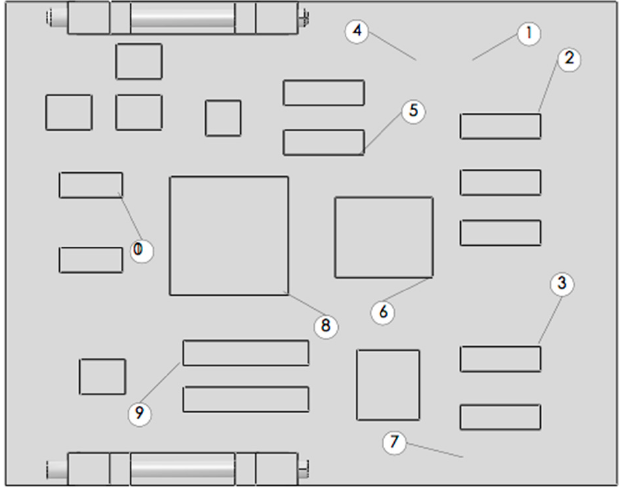
Figure 6. Ten reference points defined in the CPU board.